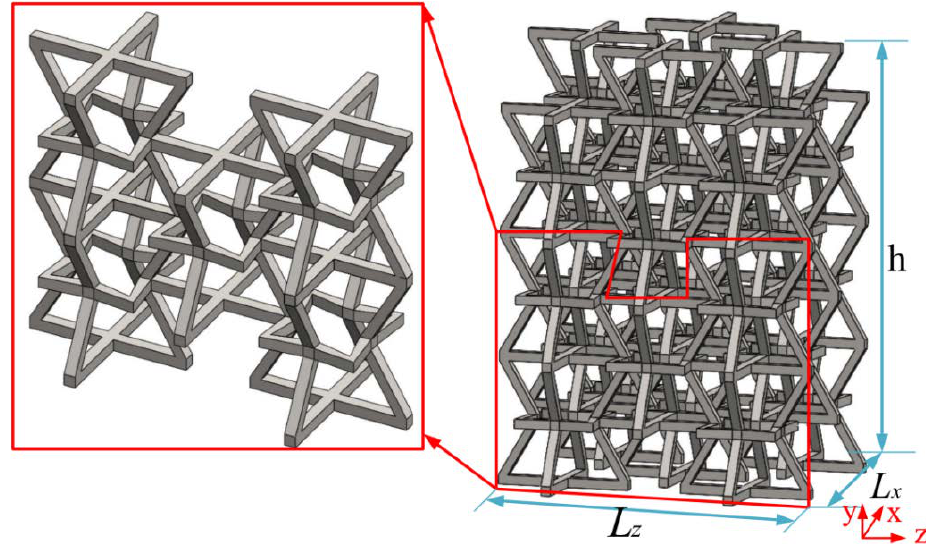
Figure 3. Modified negative-Poisson-ratio structure composition.